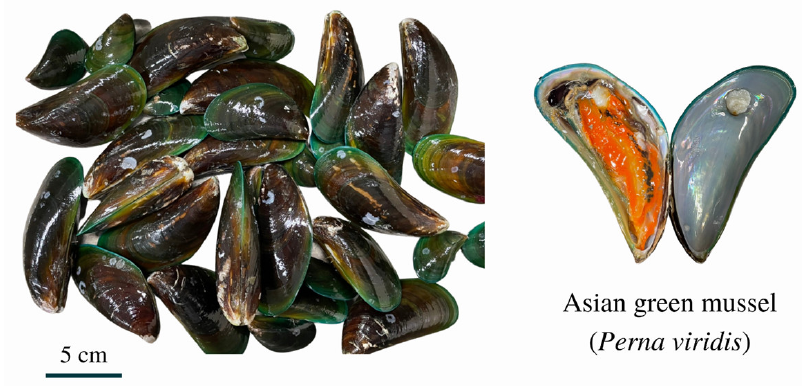
Figure 1. Asian green mussel ( Perna viridis ) collected from the south of Thailand. Table 1. Provinces, types of places, and number of V. parahaemolyticus isolates collected from the south of Thailand. Provinces Types of Places Collected Number of Samples Local